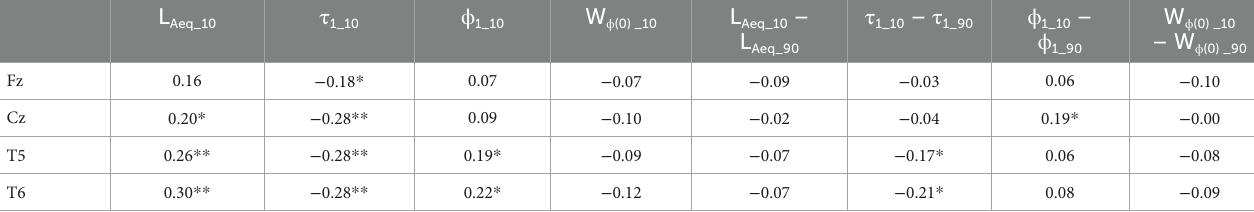
TABLE 1 The correlation coefficients between ACF factors and the RMS amplitude at Fz, Cz, T5, and T6. L Aeq_10 τ